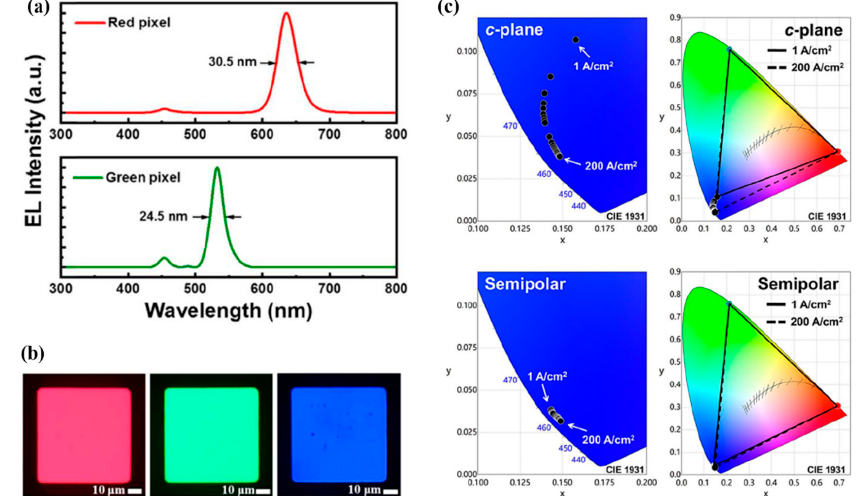
Figure 5. ( a ) EL spectra of red and green pixels. ( b ) EL image of RGB pixels. ( c ) Color gamut of RGB pixel assembly from c-plane µLED and QDPR at various current densities in CIE 1931 color space [49]. Figure reproduced with permission from Optical Society of America.